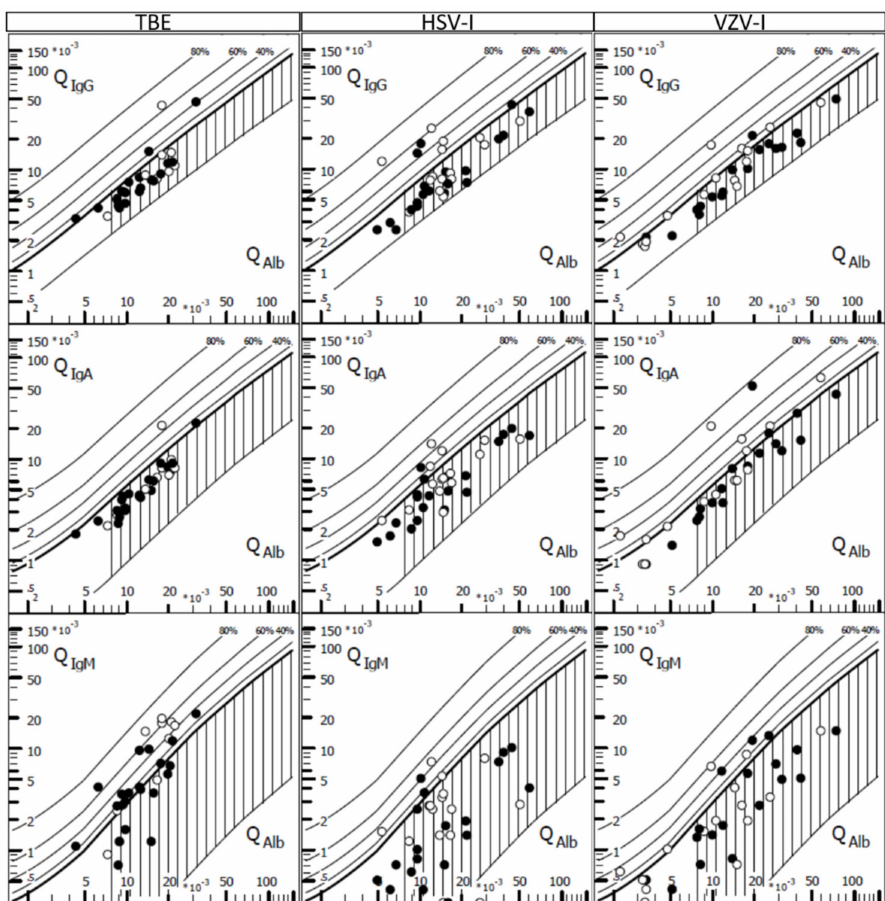
Figure 1. Intrathecal immunoglobulins in tick-borne encephalitis (TBE) and CNS infections by herpes simplex virus (HSV-I) and varicella zoster virus (VZV-I) CSF / serum quotient diagrams for IgG, IgA and IgM with hyperbolic discrimination functions in tick-borne encephalitis (TBE), and CNS infections by herpes simplex virus (HSV-I) and varicella zoster virus (VZV-I). The upper curve of the reference range represents the discrimination line between brain-derived and blood-derived immunoglobulin fractions in the CSF. Filled figures indicate first diagnostic lumbar puncture and open figures indicate one follow-up lumbar puncture. Graphic Program by Albaum IT-Solutions was used to visualize the Reiber